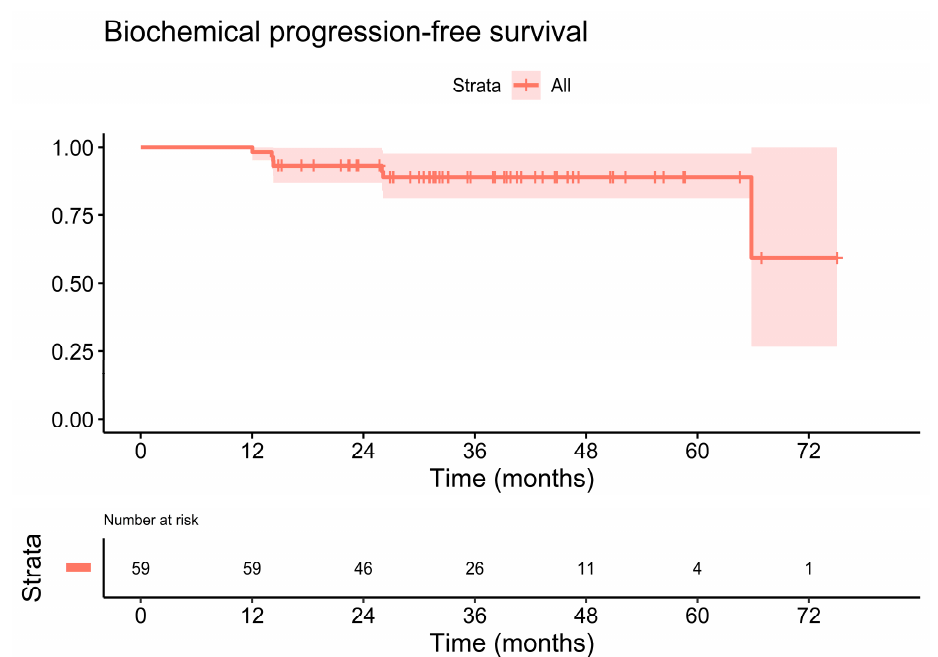
Figure 2. Kaplan-Meier plot of the biochemical progression-free survival. The estimated three-year